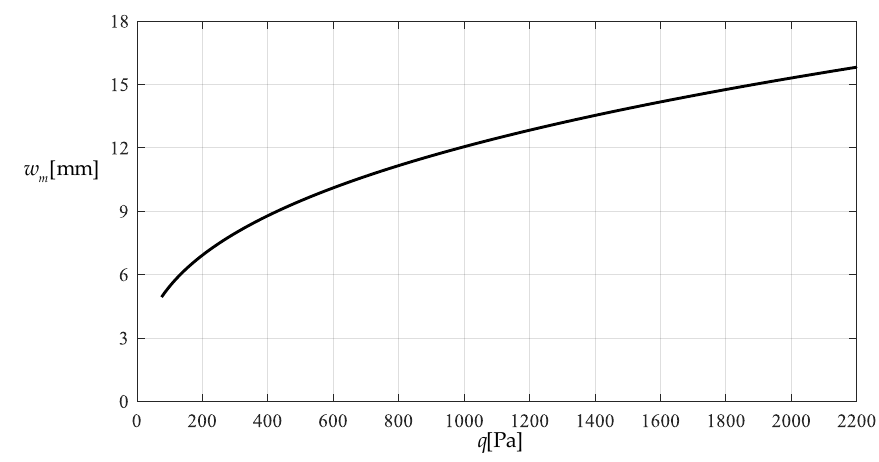
Figure 13. Variation of w m with q .